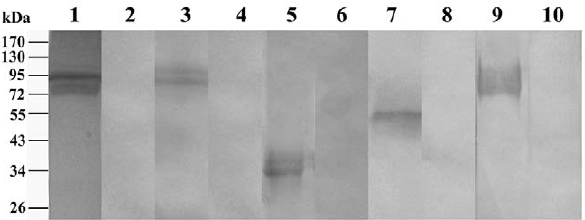
Figure 2. Immunoblot profiles of five parasites confirmed as food-borne helminthiases with corresponding sera. Lanes 1, 3, 5, 7 and 9 represent the semi-purified antigens of C. cellulosae , A. cantonensis , P. westermani , T. spiralis and Spirometra plerocercoids recognized by the corresponding sera of the patients, respectively. Lanes 2, 4, 6, 8 and 10 represent the semi-purified antigens of C. cellulosae , A. cantonensis , P. westermani , T. spiralis and Spirometra plerocercoids recognized by the sera of healthy adult, serving as an example.